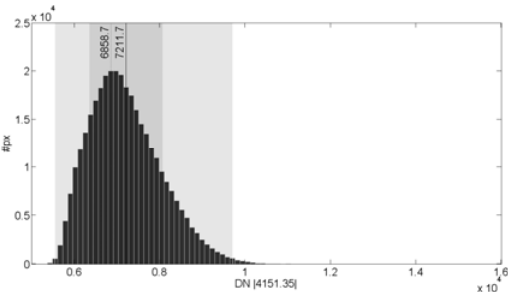
Figure 6: Image histogram with mean (solid line) and median (dotted line) value of the DN. a) 10° image; b) 70° image.